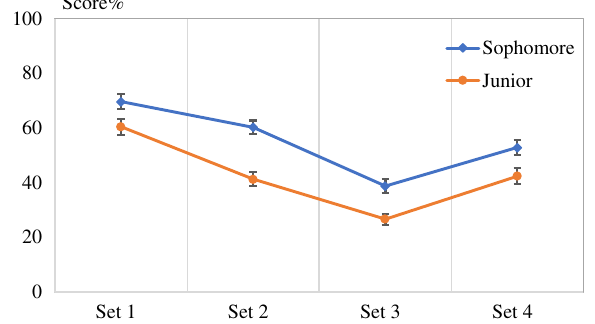
FIG. 3. Students ’ performance across different question sets. The error bars represent standard error.